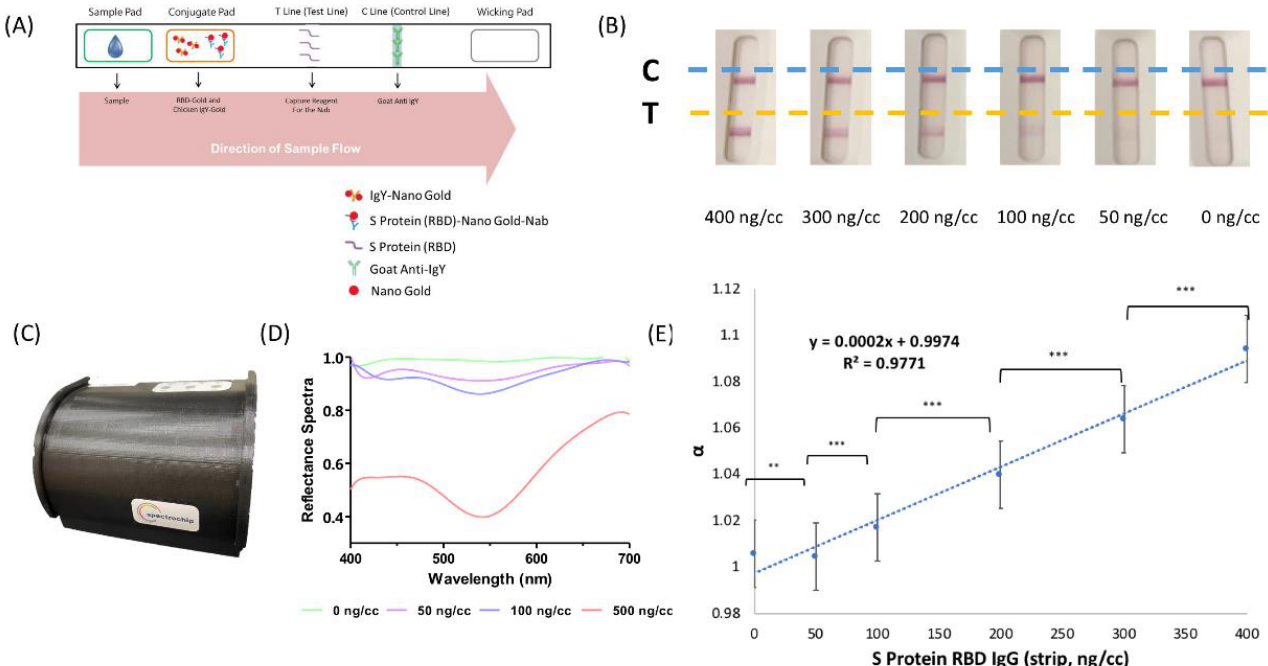
Figure 1. ( A ) The colorimetric change mechanism aspect of the lateral flow immunoassay strip. ( B ) The colorimetric change in a lateral flow rapid test strip for detecting neutralizing antibodies. The control line is shown as a blue dotted line, the test line as a yellow dotted line. ( C ) The spectrum analyzer used in our study. The analyzer can load a lateral flow immunoassay and can be used in combination with a spectrum-based reader. ( D ) The reflectance spectra range of the control line and test line. ( E ) Standard curve of SRBD IgG by a lateral flow immunoassay/spectrum analyzer. SRBD, spike protein receptor binding domain; ** p < 0.01; *** p < 0.001.